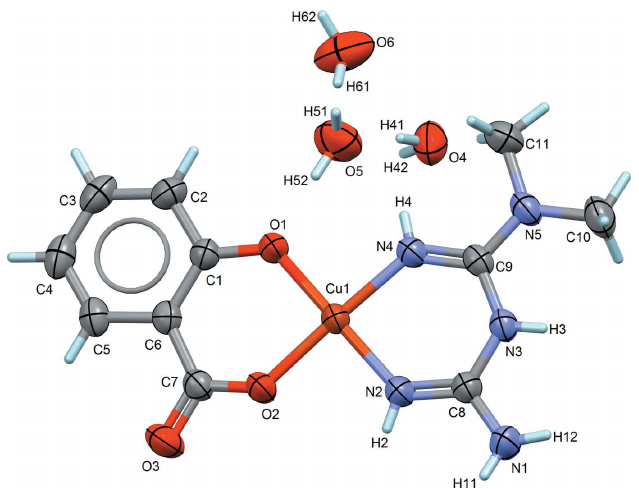
Figure 1 The structure of the molecular entities present in the title compound, with displacement ellipsoids for non-H atoms drawn at the 60% probability level. Labelled atoms are those for which coordinates were refined